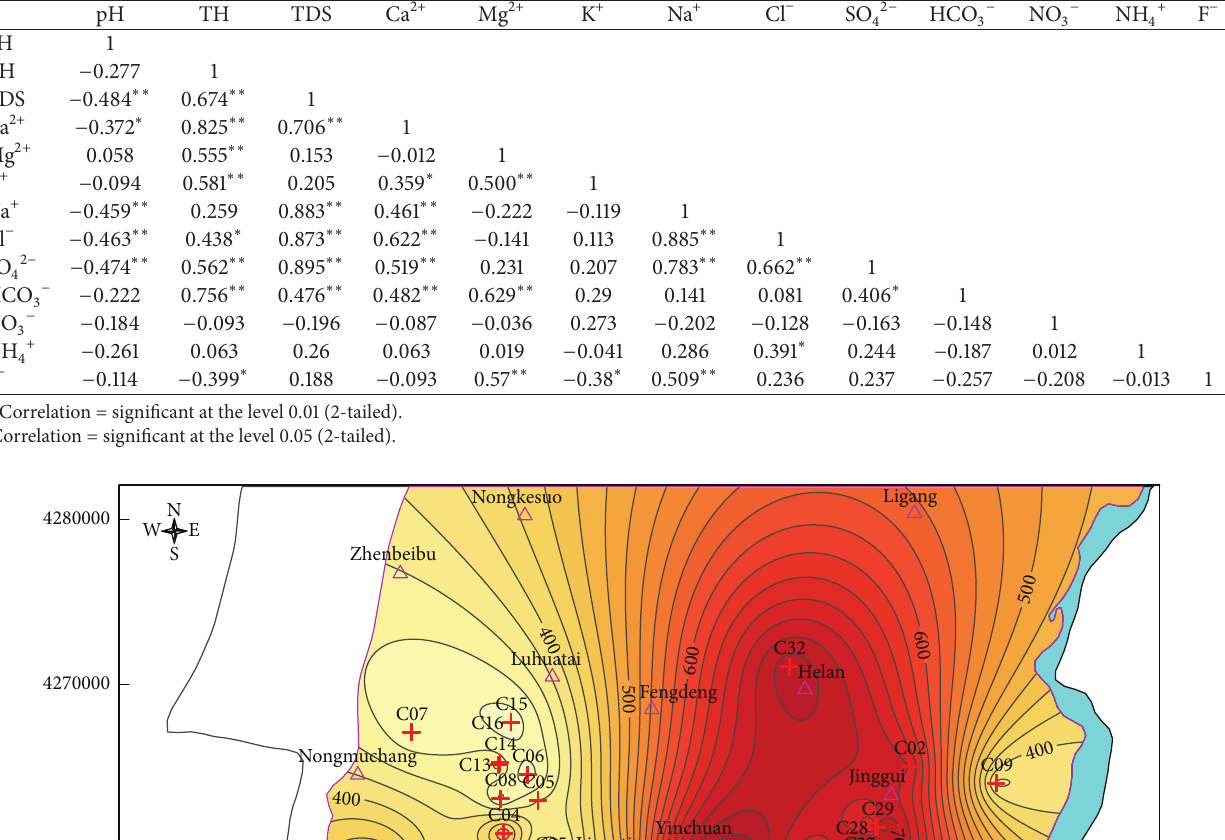
Table 2: Correlation matrix of the 13 physicochemical water parameters. The values are the correlation coefficients ( 𝑟 ).